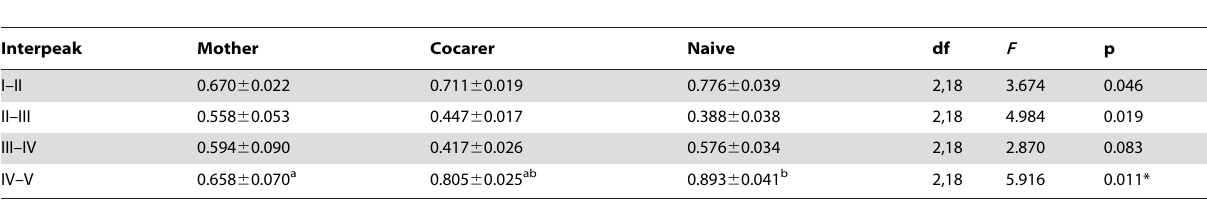
Table 2. Click-evoked ABR interpeak latencies measured 20 dB above each animal’s threshold.